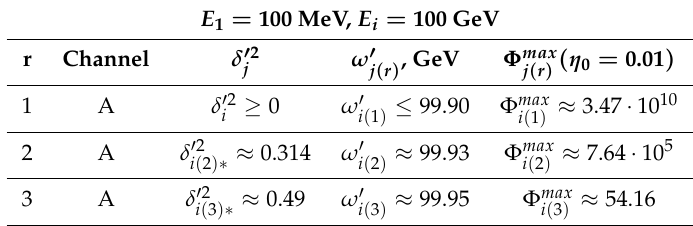
Table 2. The magnitudes of the differential cross-section ( Φ max δ (cid:48) 2 , j = i (30) for channel A for the r = 1, 2, and 3 resonances when the energies of the initial electrons j have magnitude of E i = 100 GeV (in such conditions channel B is essentially suppressed in comparison to the channel A). The data indicates that the anomalous emission of high-energy gamma-quanta is